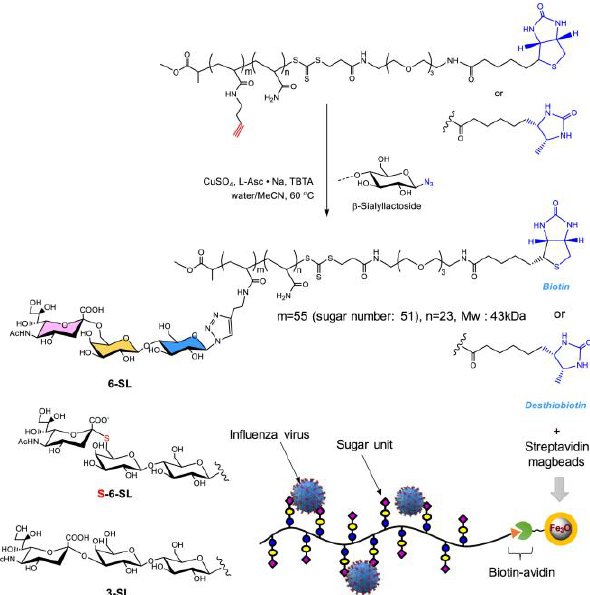
Figure 15. Chemical structures and schematic procedure for the preparation of the glyco − magbeads. Figure reproduced from ref. [69] with permission.